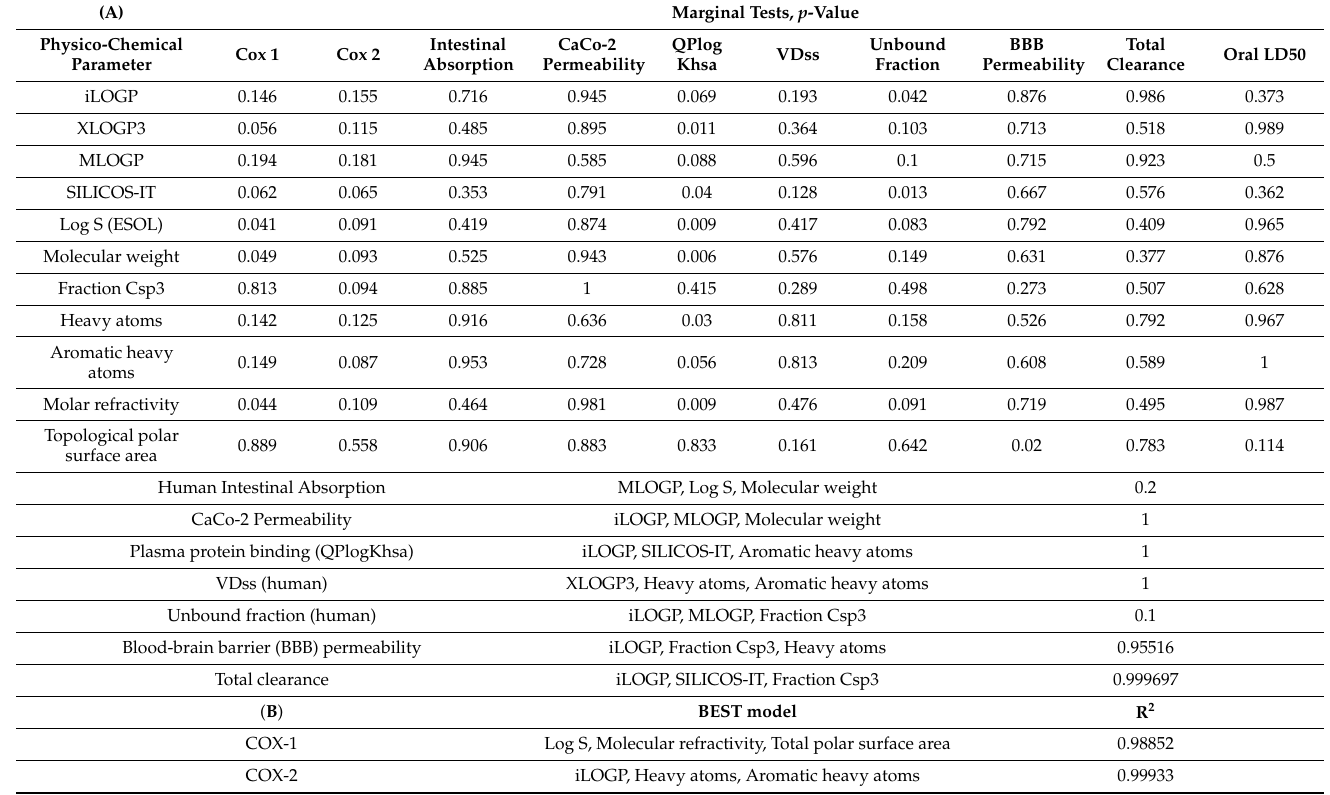
Table 5. Outcomes of the distance-based linear models for the biological predictions and physicochemical properties of aspirin and the brominated indoles from Dicathais orbita . ( A ) p -values from the marginal tests for each individual variable. ( B ) Overall BEST solution from the combined models, with a proportion of the variation explained (R 2 ).